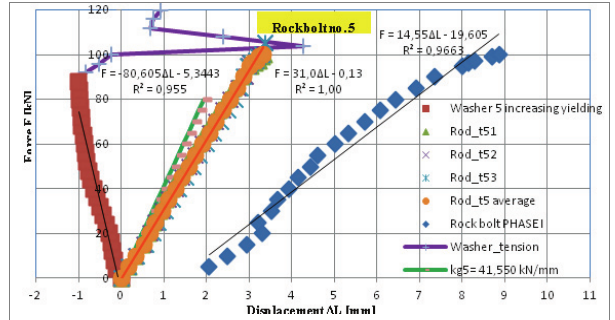
Fig. 25. The detailed loading characteristics for the components of the rock bolt support No.